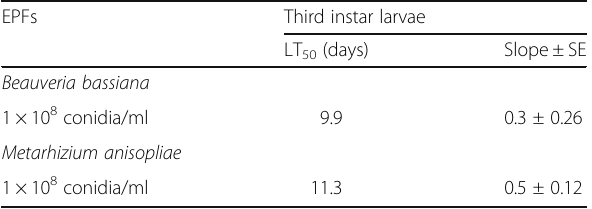
Table 2 LT 50 of entomopathogenic fungi (EPFs) at the indicated concentration applied against the third instar Oryctes agamemnon